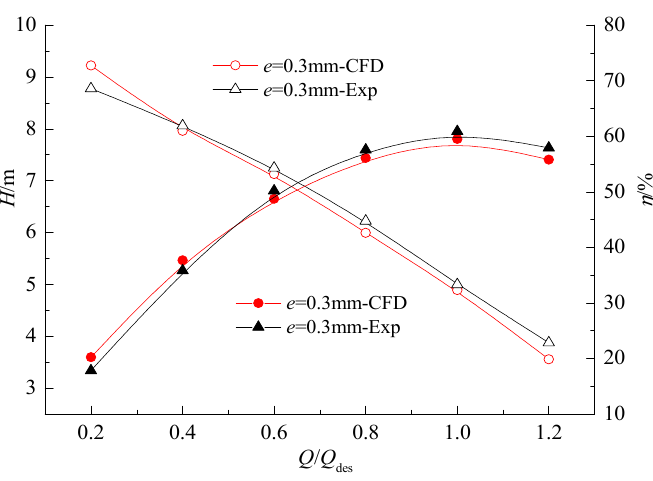
Figure 10. The comparison of external characteristics.